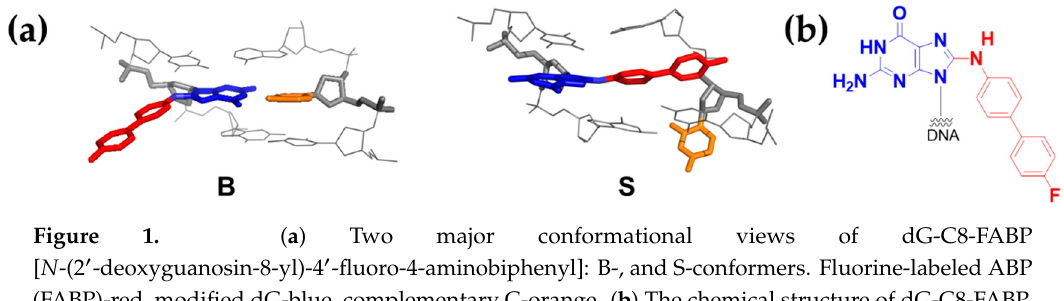
Figure 1. ( a ) Two major conformational views of dG-C8-FABP [ N -(2 ′ -deoxyguanosin-8-yl)-4 ′ -fluoro- 4-aminobiphenyl]: B-, and S-conformers. Fluorine-labeled ABP (FABP)-red, modified dG-blue, complementary C-orange. ( b ) The chemical structure of dG-C8-FABP.